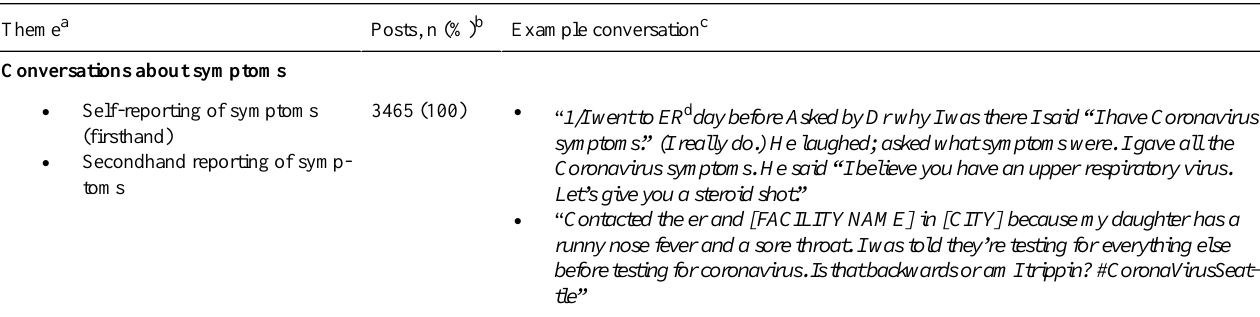
Table 1. Numbers and examples of posts related to COVID-19 symptoms, access to testing, and recovery (modified for deidentification; n=3465).